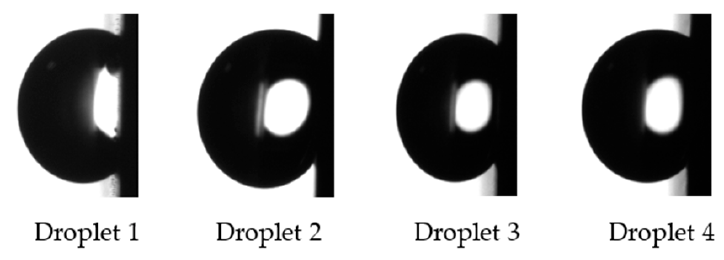
◦ of inclination on the samples textured in ambient Figure 12. Droplets still present at 90° of inclination on the samples textured in ambient air. Figure 12. Droplets still present at 90